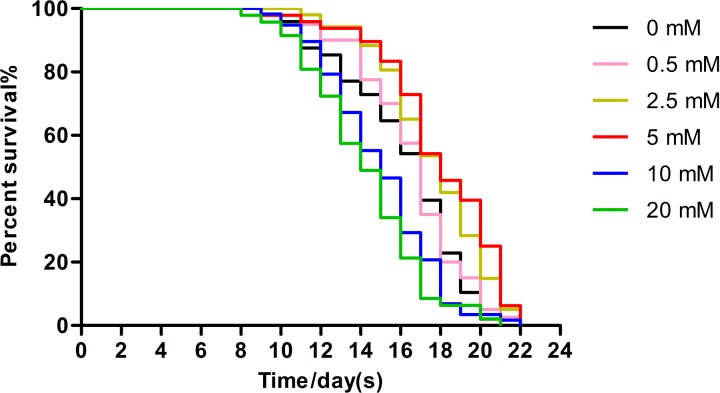
Effect of arbutin on the lifespan in C. elegans.Wild type animals (N = 120–182 in each group) were treated without (0 mM) or with low (0.5, 2.5 mM), moderate (5 mM) and high (10, 20 mM) concentrations of arbutin at 20 °C from birth, when survival was monitored. The experiment was repeated multiple times and a representative trial was shown. Statistical difference between the curves was analyzed by log-rank test (Fig. 1, p < 0.0001).